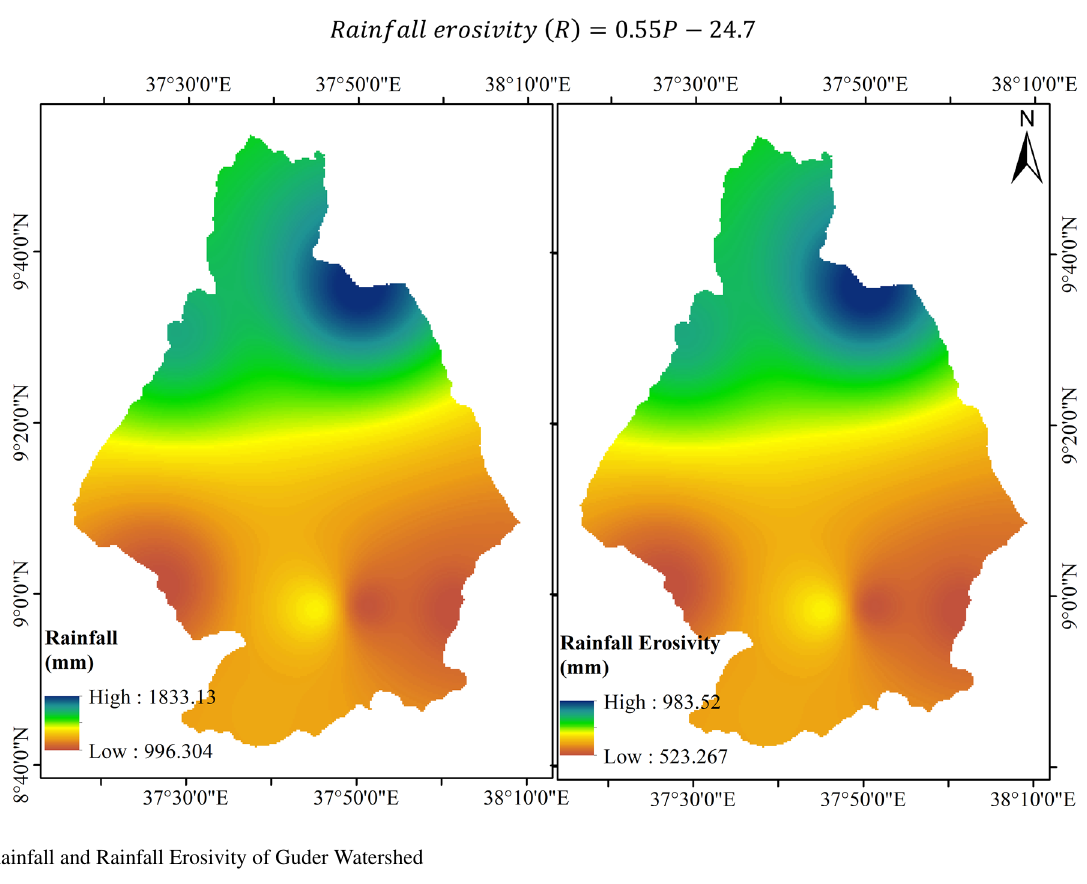
Fig. 5 Rainfall and Rainfall Erosivity of Guder Watershed Fig. 6 Topographic Wetness Index of Guder